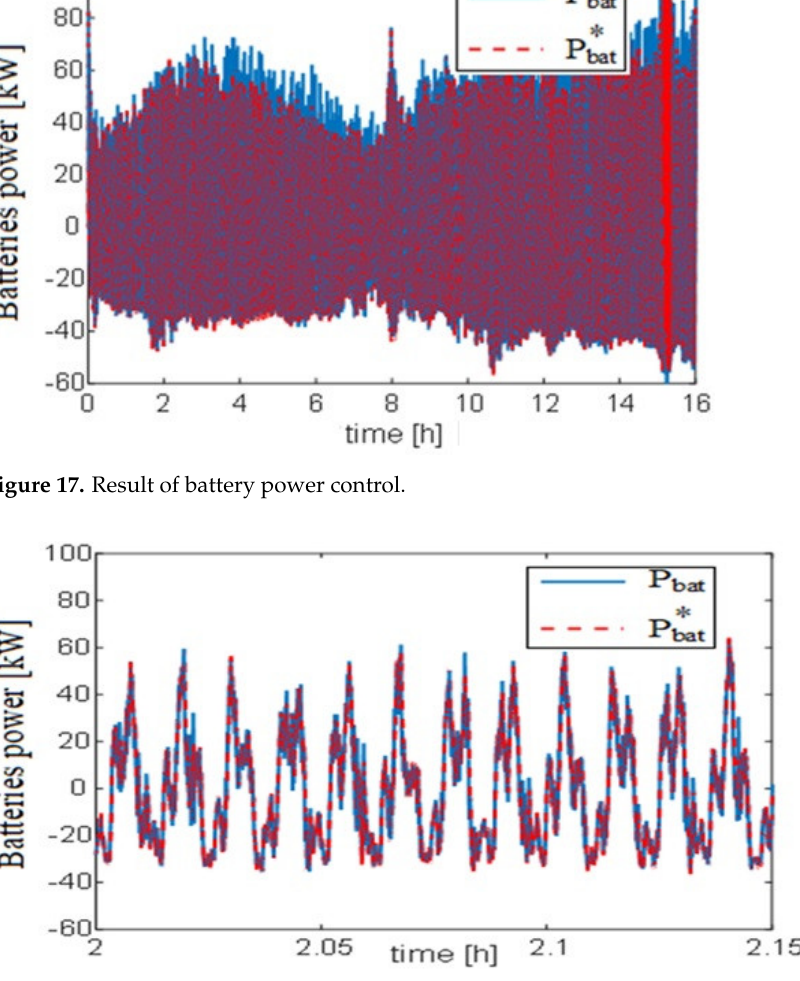
Figure 18. Close-up of Figure 17.